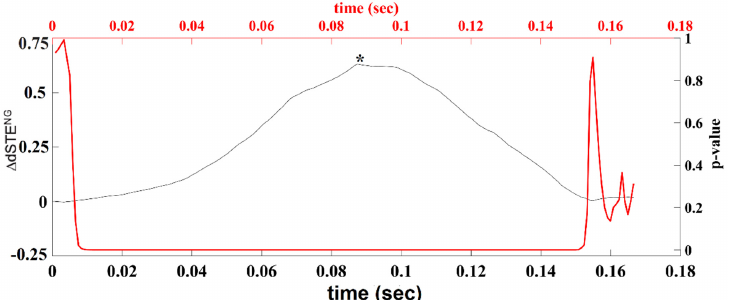
Figure 3. Time-lag estimation between the left precentral gyrus and left superior parietal lobule time series filtered in the δ -band frequency. The example is from a 20-year-old male subject. The black time series illustrates the Δ dSTE NG values for each ms in the displayed 167 ms range. The red time series demonstrates the p -values computed for each time lag (ms) after applying surrogate analysis. The p -values surrounding the maximum Δ dSTE NG are significant ( p < 0.01). Finally, we selected the maximum and significant value of Δ dSTE NG , which is 1.33 at the time lag of 0.08 s. The horizontal red line extends over the significant time lags around that with maximum Δ dSTE NG value. The left x -axis corresponds to the strength ( Δ dSTE NG ) of the coupling, whereas the right x -axis ( red ) corresponds to the p -values.